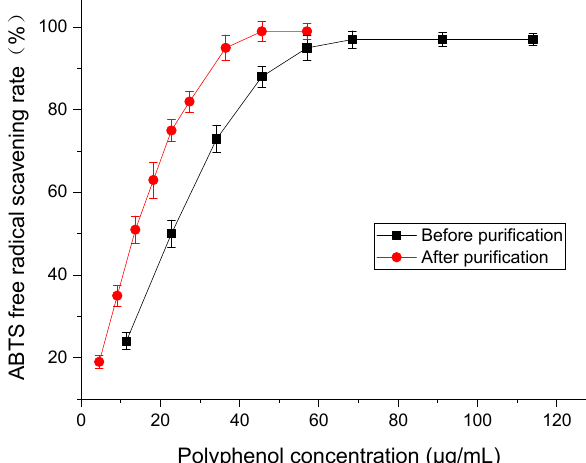
Figure 10. ABTS free radical scavenging rate of polyphenol from distiller’s grain before and after purification by D101 resin under the condition of 30 °C at 120 rpm for 24 h and eluted with 60% ethanol. Vertical bars represent the standard deviation of each value.